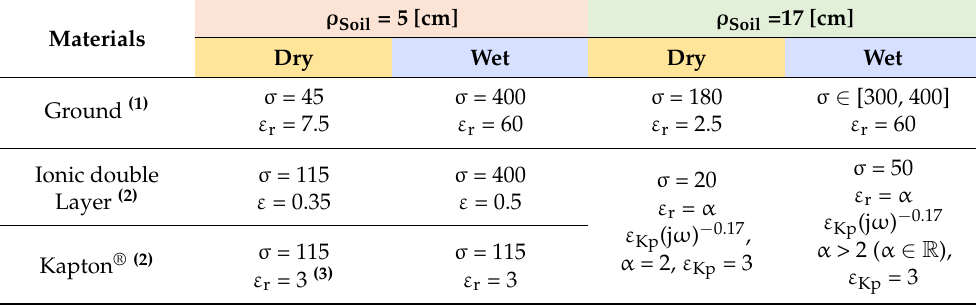
Table 4. Obtained parameters once refined until reaching convergence between measured and simulated spectra from dry to wet (2 L leak) situations for shallower and thicker terrain setups. In the latter, the ionic double layer and the polyimide one were unified for a better consistency. The background colors on the table act as a reinforcement for the arid soil (yellowish) counterposing the wet one (blue), whereas the incorrect setup radius (light red) opposes the corrected one (light green). Materials Ground (1) Ionic double Layer (2) 3Kapton ® (2)